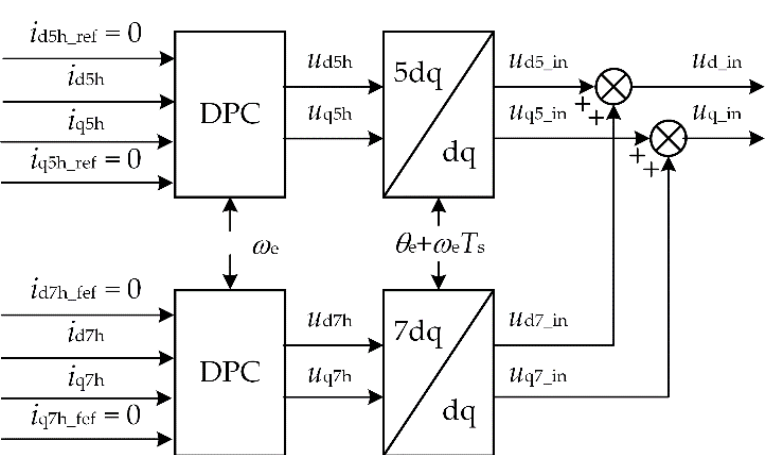
Figure 4. The block diagram of traditional current harmonic controller-based on DPC. This strategy effectively avoids complex parameter tuning and is easier to implement digitally. However, this strategy depends on the motor parameters, and the model error caused by the rotor position variation within one control cycle cannot be ignored due to the higher electrical angular frequency of the motor in the 5th and 7th synchronous rotating frames. This will degrade the control performance of the current harmonic controller,